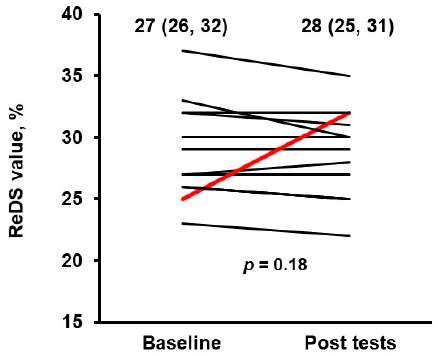
Figure 2. Change in ReDS values before and after cardiopulmonary exercise tests. p value was calculated by Wilcoxon signed-rank test. Table 1. Baseline characteristics.